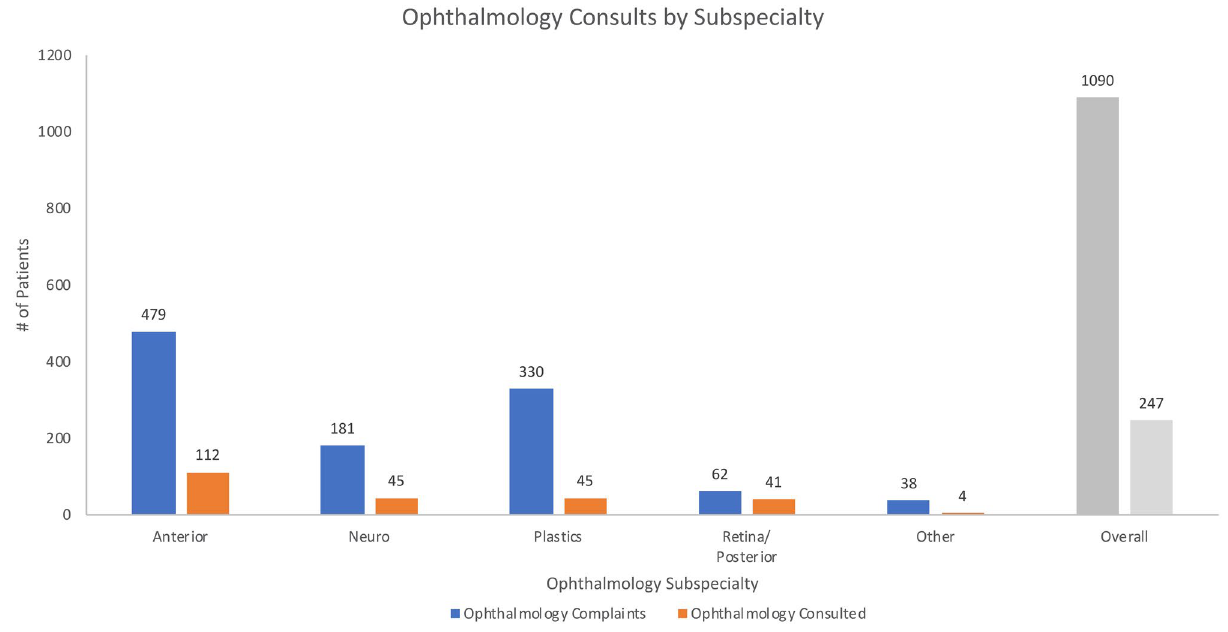
Figure 3. Ophthalmology consults by ophthalmologic